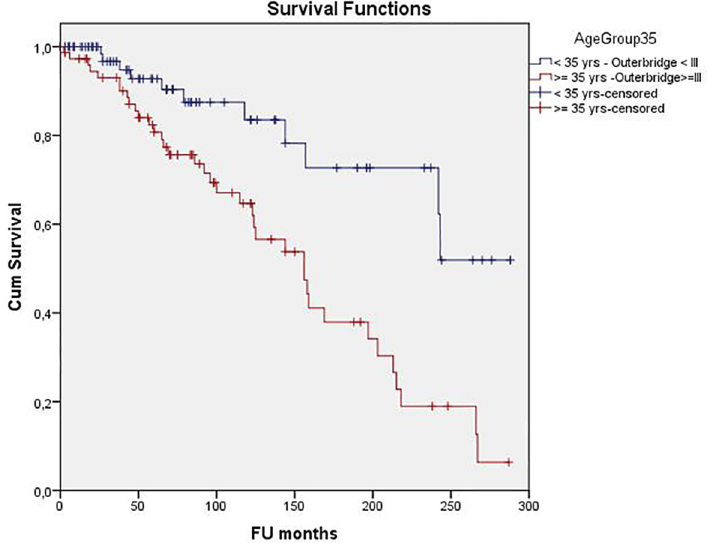
Fig 7. Kaplan-Meier survivorship curve (blue line) of the best case scenario (age < 35 years at surgery and cartilage Outerbridge grade < III: n = 85) versus Kaplan-Meier survivorship curve (red line) of the worst case scenario (Age ≥ 35 years at surgery and Cartilage Outerbridge grade ≥ III: n =